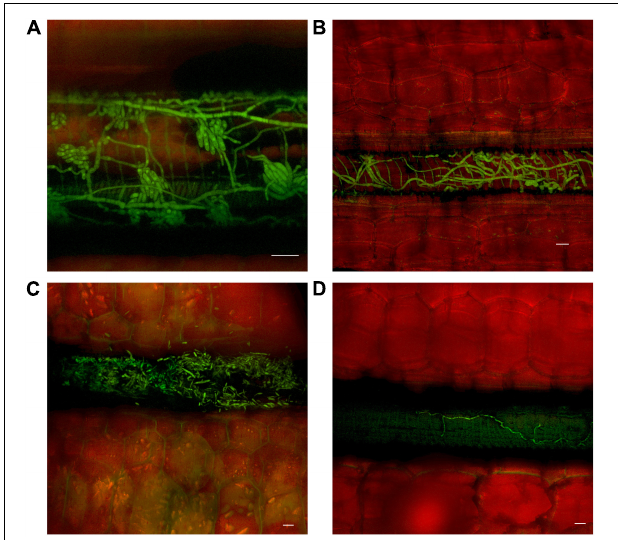
FIGURE 5 | Presence of fluorescing Fusarium oxysporum f.sp. cubense on the outer surface of dead or senescing leaf sheaths on Cavendish banana plants. (A) 80 dpi at 15–20 cm above the rhizome shows hyphae emerging from stoma on the outside of the leaf sheath. (B) 70 dpi at 0–5 cm above the rhizome showing hyphae and apparent sporodochia emerging from stoma on the outside of a leaf sheath. (C) 50 dpi at 10–15 cm above the rhizome showing mycelium present on the outer leaf sheath surface and sporodochia. (D) 40 dpi at 10–15 cm above the rhizome, prolific macroconidia presence on the outer leaf sheath surface. Scale bars represent 20 µ